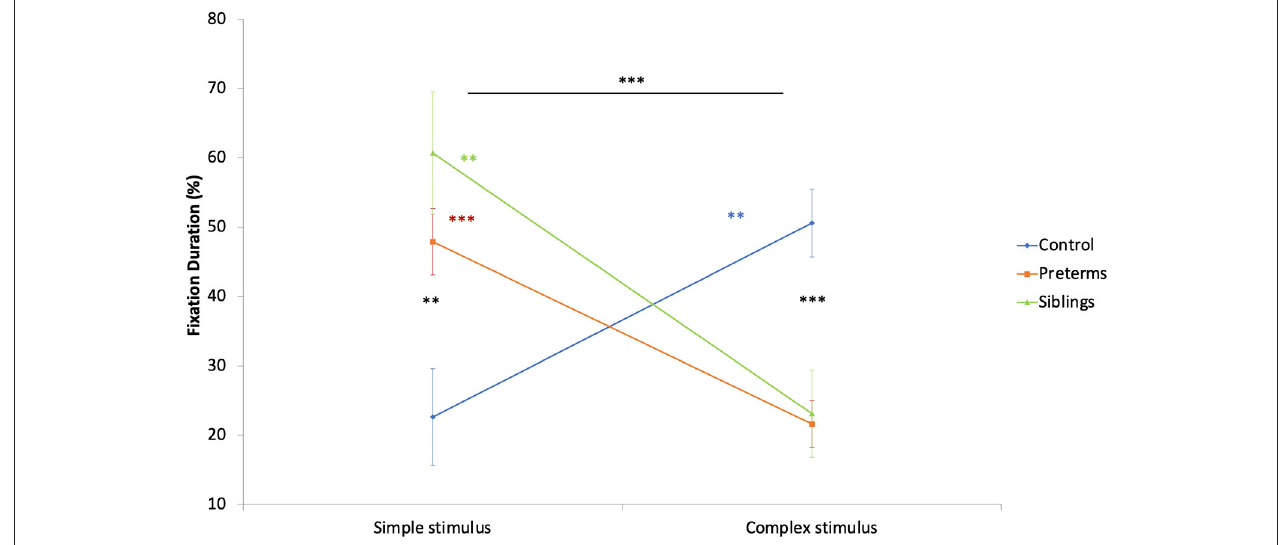
FIGURE 5 | Fixation duration during the GISP task as a function of stimulus type and risk group. ** p < 0.01, *** p < 0.001.